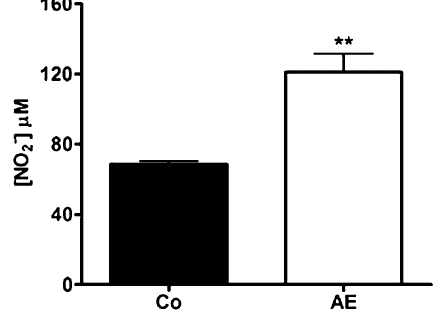
Figure 5. Effect of acute aerobic exercise (AE) on nitrite [NO 2 ] cerebrospinal fluid (CSF) levels. Immediately after AE (open bar), the cerebrospinal fluid levels were increased compared to the control group (Co, shaded bar). Data are reported as means±SE of 5 animals per group. **P , 0.01, compared to Co (non- exercised rats) ( t